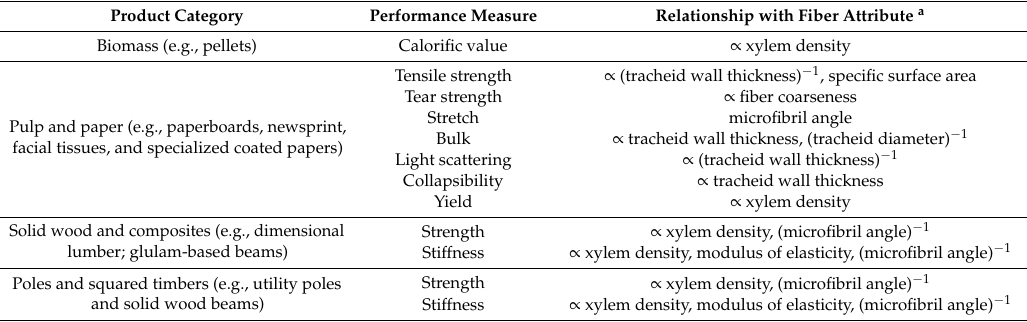
Table 1. Product-based performance measures and their relationship with fiber attributes for boreal